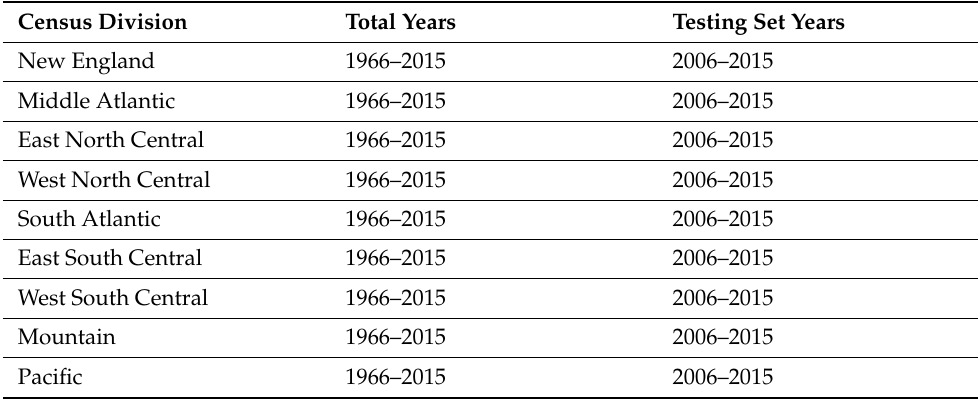
Table 1. Total and testing set years by